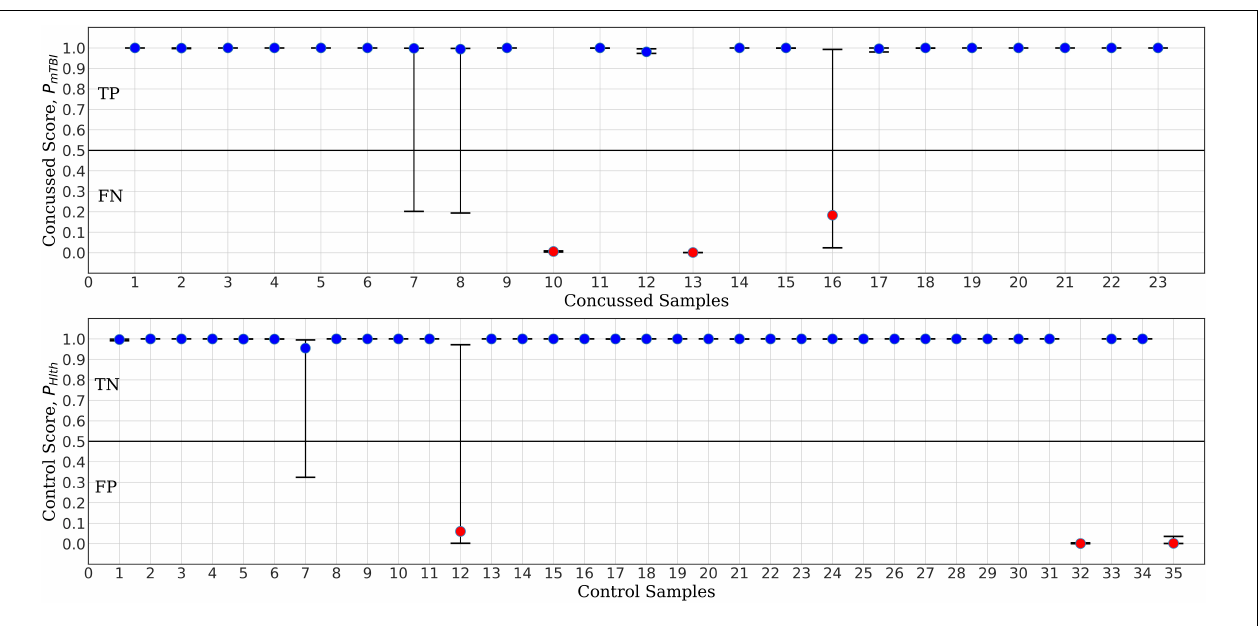
FIGURE 7 | ConcNet 2 MCCV classification test output scores (circle markers), i.e., P Hlth and P mTBI , respectively, for control (bottom) and concussed (top) participants. These results are based on information from all 64 EEG channels. The horizontal axis marks the different participants in each group, and the vertical axes correspond to test output scores in the range [0, 1]. The error bars are based on the classification results of 100 Monte Carlo cross validation experiments. Blue markers correspond to participants who were correctly classified at least 50% of the time, while red markers correspond to misclassified participants (median classification score less than